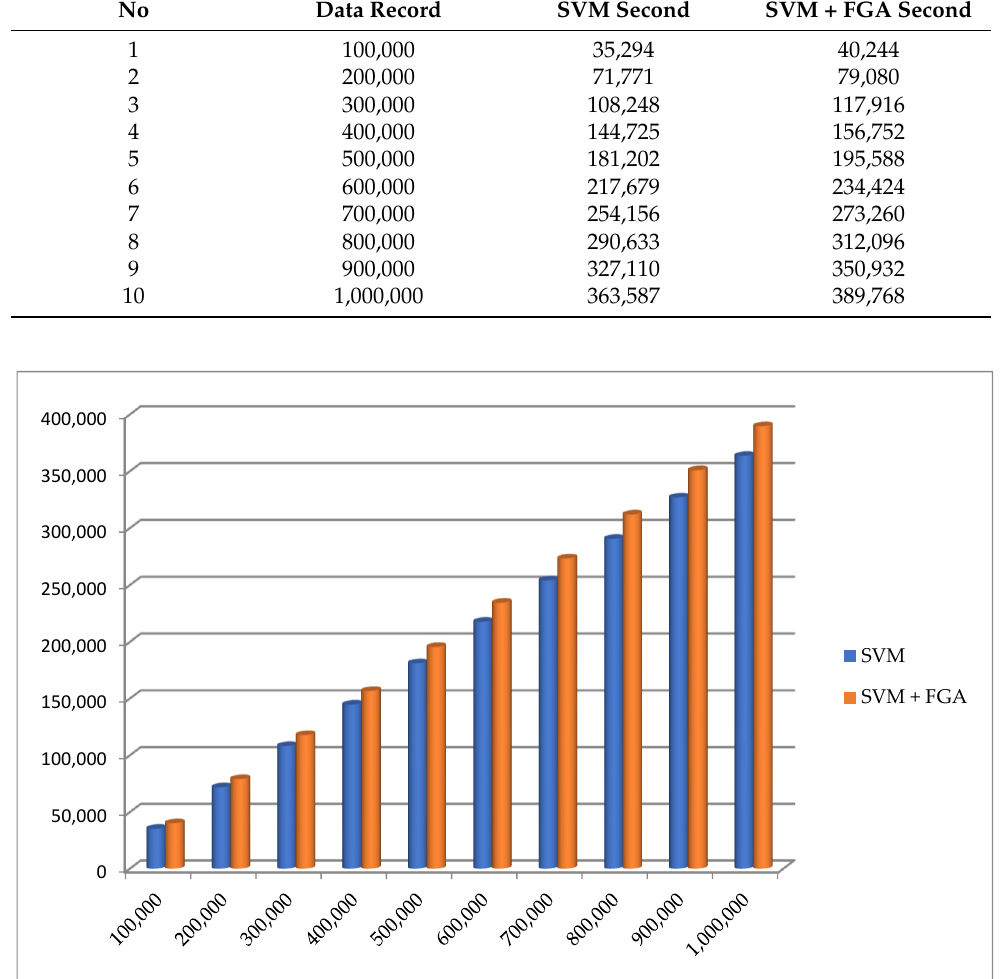
Figure 6. Graph of computational performance of SVM and SVM using FGA.